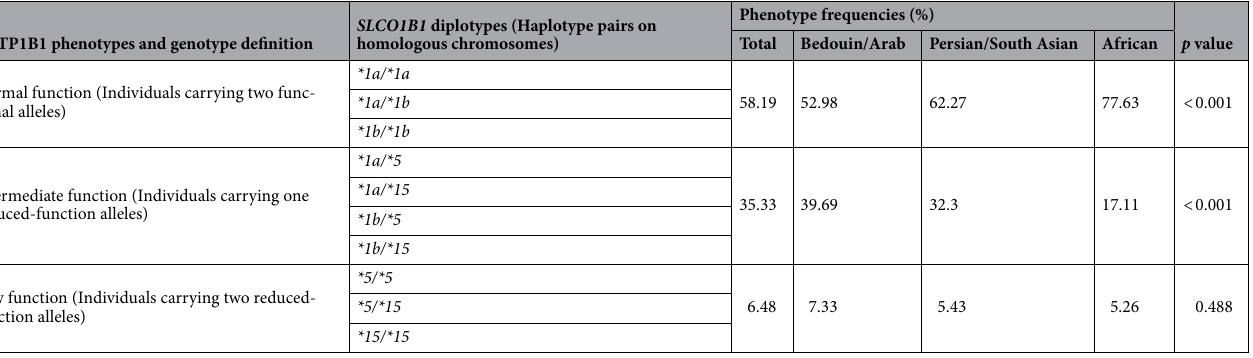
Table 3. OATP1B1 phenotypes based on SLCO1B1 diplotypes in Qatar across the three different ancestry